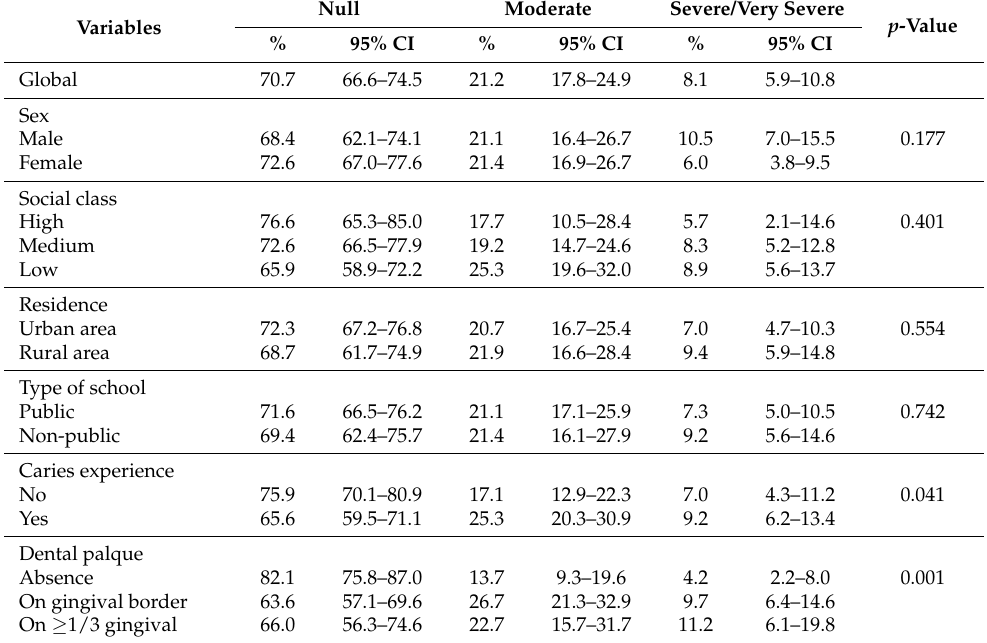
Table 4. Presence and severity of malocclusion by socio-demographic and oral health variables and estimation of the association between the presence of malocclusion and the different variables in 15-year-old